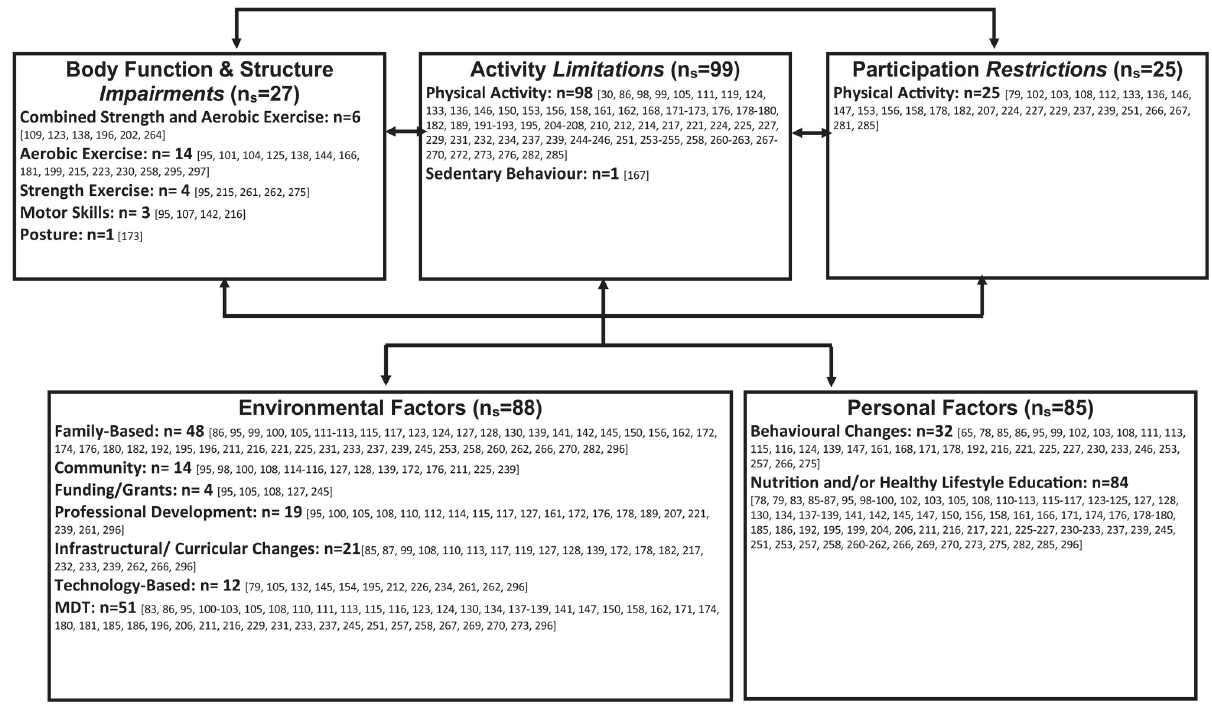
Fig 3. ICF-CY model with mapped